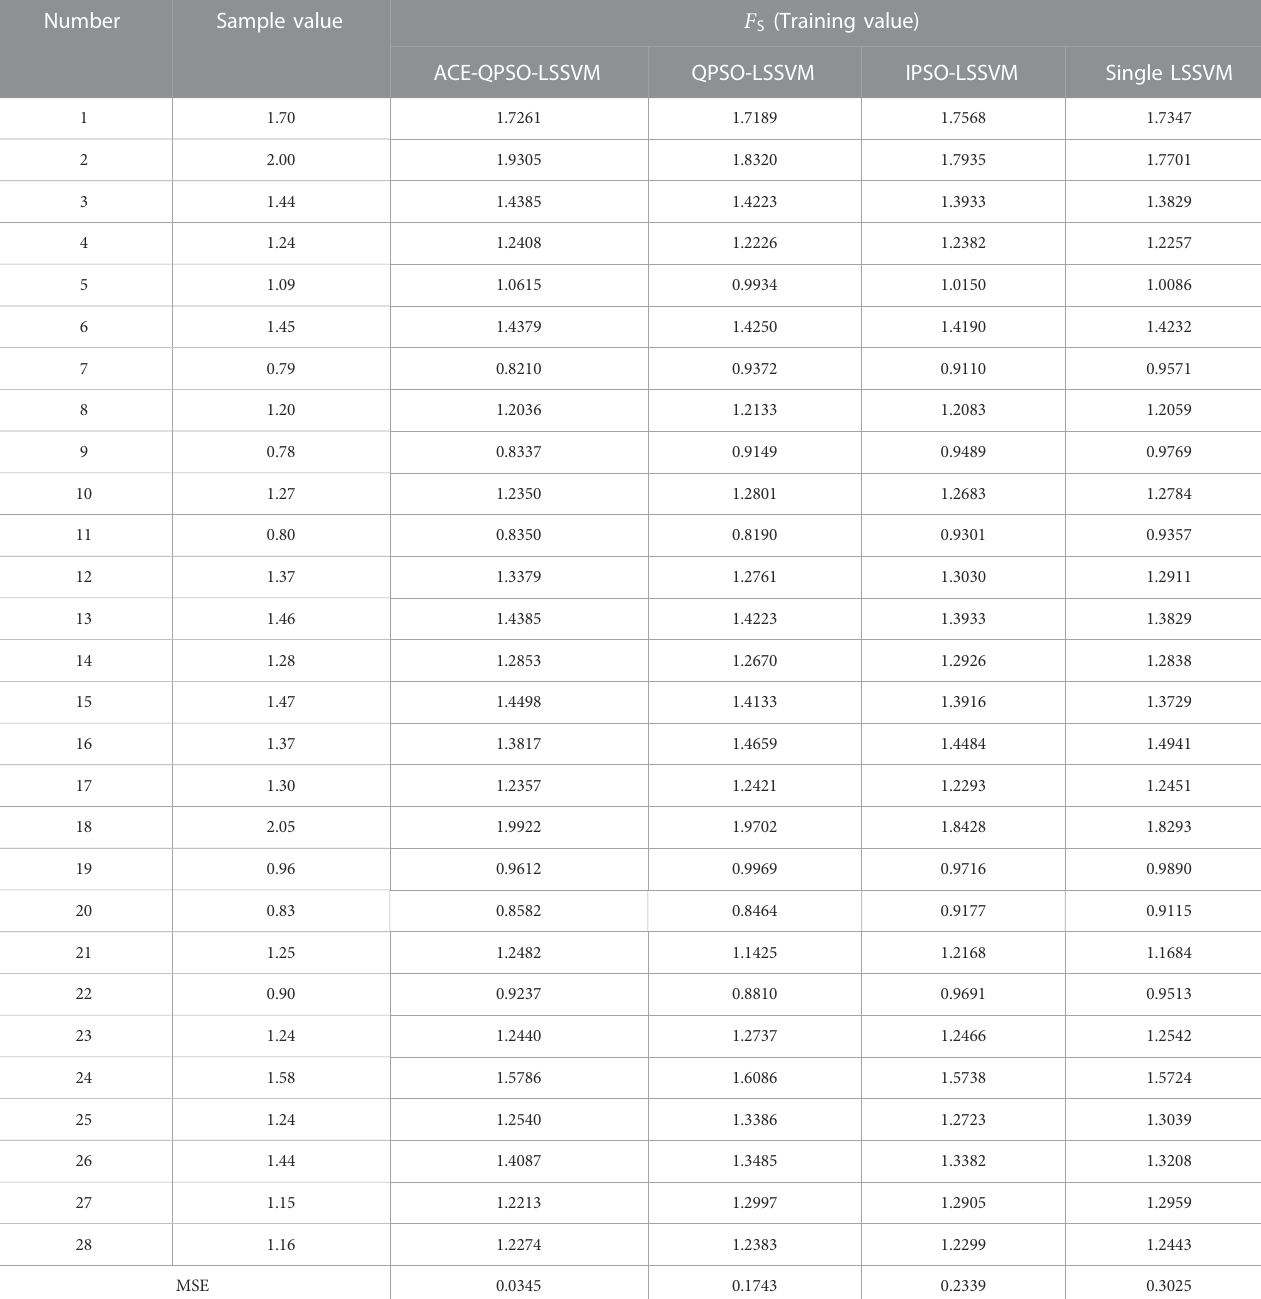
TABLE 4 Comparison between target and estimated values from each algorithm for the training